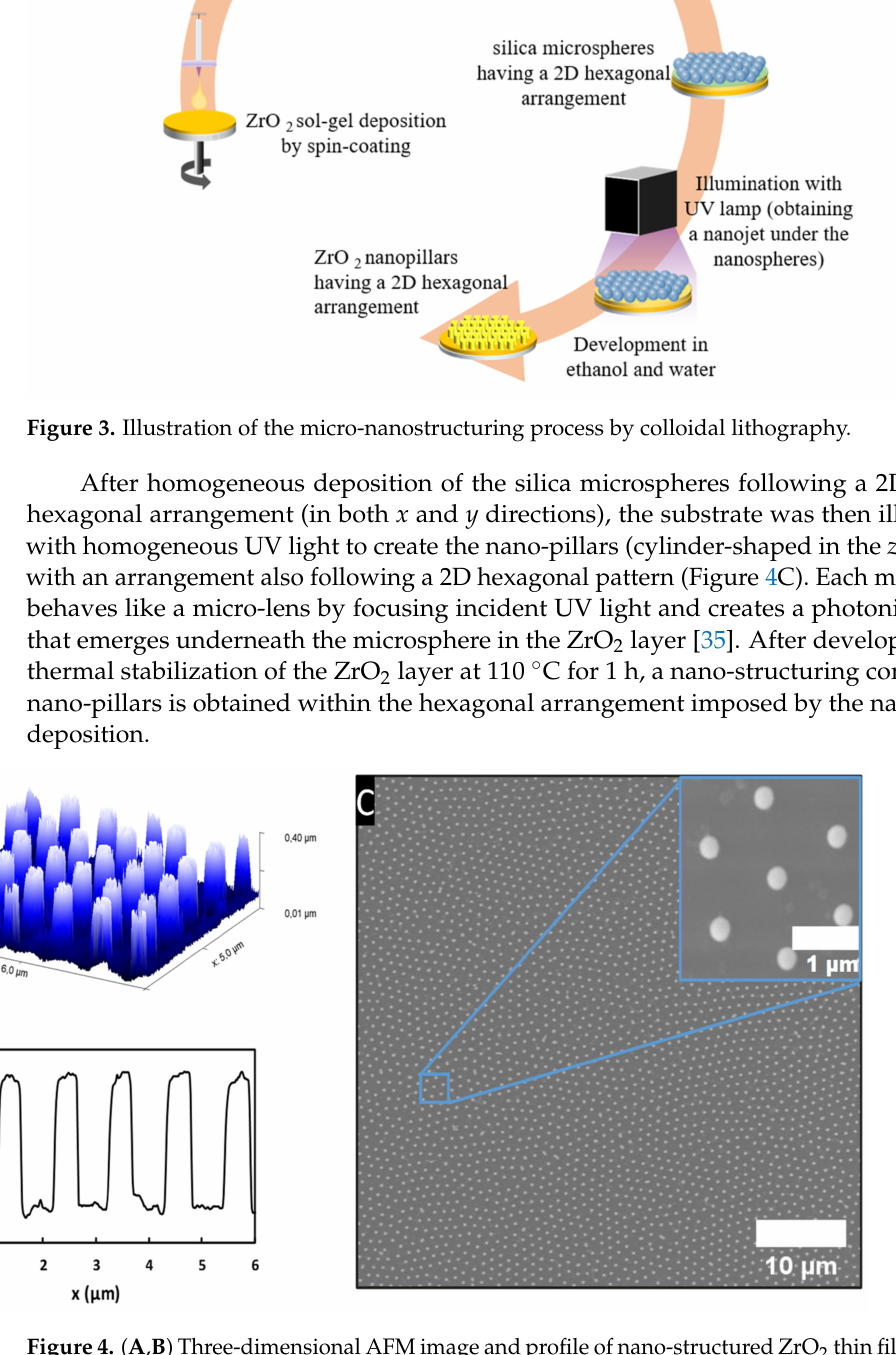
Figure 4. ( A , B ) Three-dimensional AFM image and profile of nano-structured ZrO 2 thin film. ( C ) SEM top view image of the ZrO 2 nano-pillars with an inset picture showing the hexagonal arrangement of the